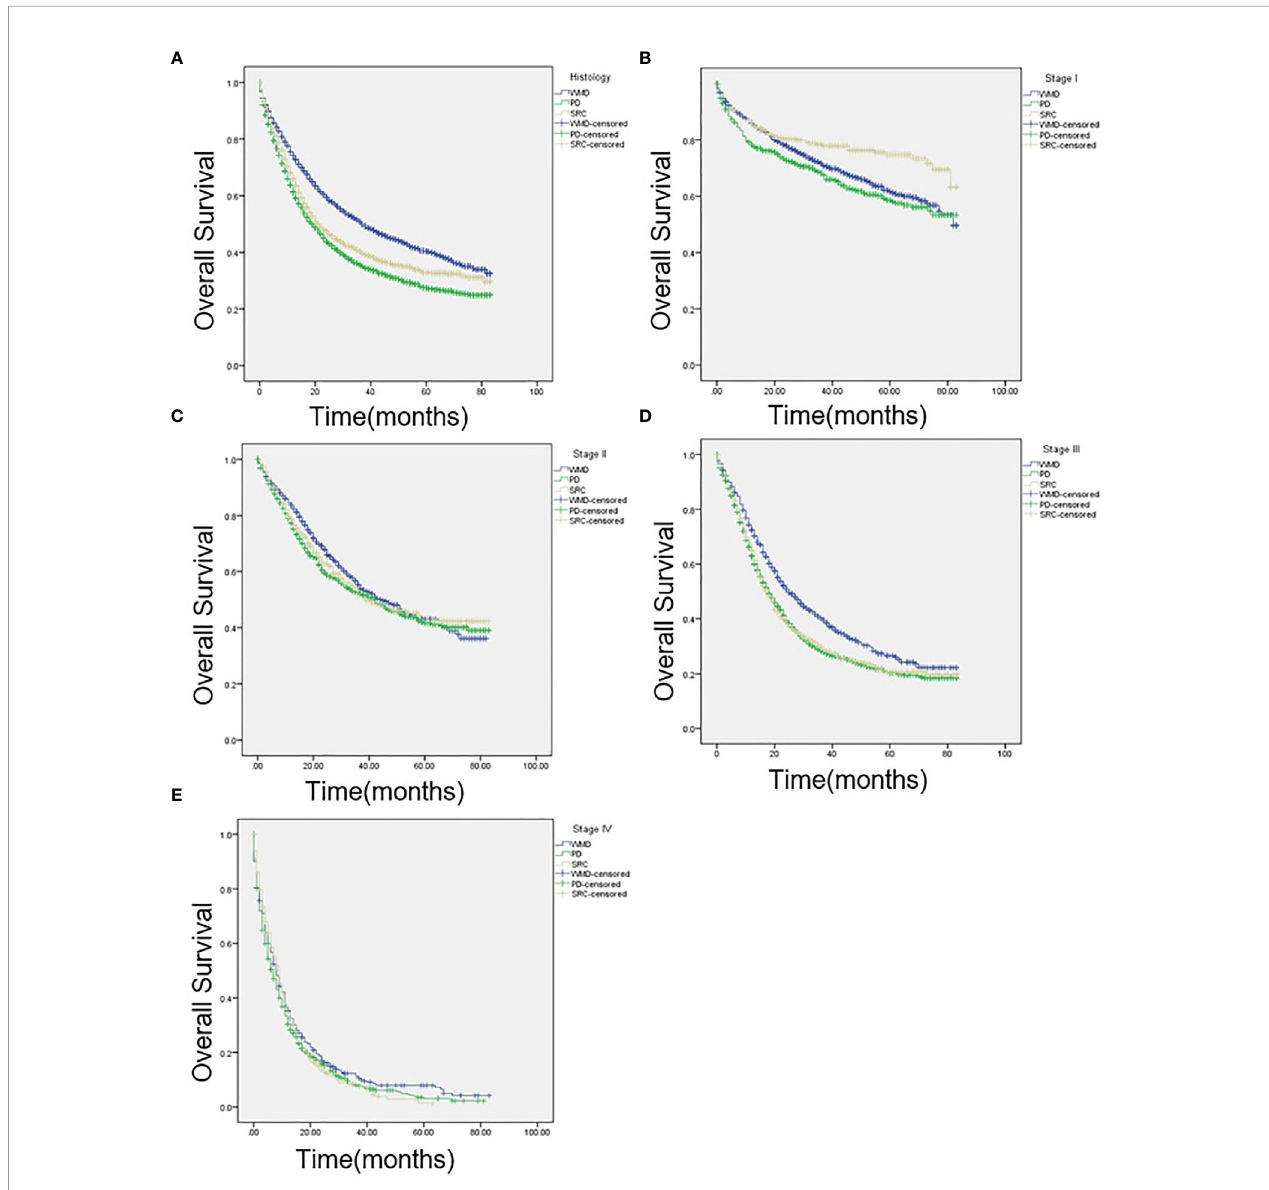
FIGURE 2 | (A) Kaplan-Meier (KM) survival curves comparing the OS of patients with signet ring cell carcinoma (SRC), well-to-moderately differentiated (WMD), and poorly differentiated (PD) adenocarcinoma of all stages, (B) at American Joint Committee on Cancer, 7th edition (AJCC) stage I, (C) AJCC stage II, (D) AJCC stage III, and (E) AJCC stage